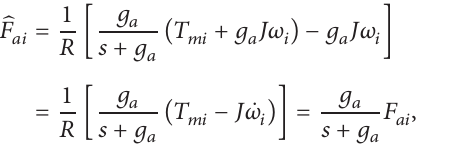
Figure 1: Adhesion property of HSTs.